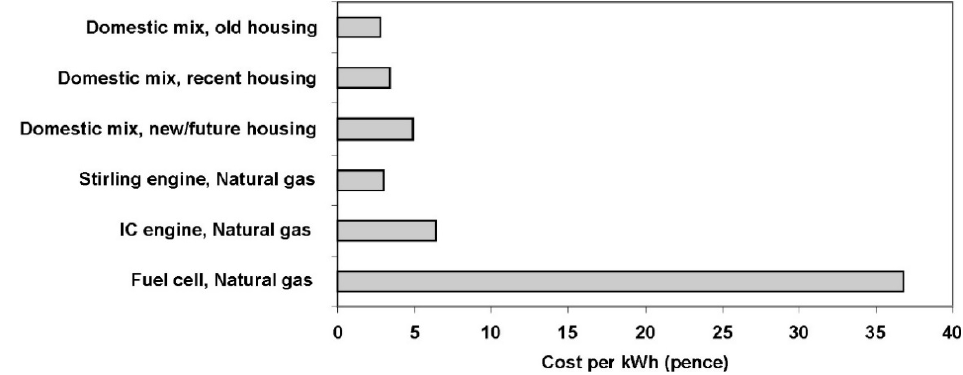
Figure 13. Micro-CHP plant DCF levelised cost per kWh of fuel and installed hardware. Source: Reprinted with permission from Ref. [18]. 2011, University of Nis—Faculty of Mechanical Engineer- ing.